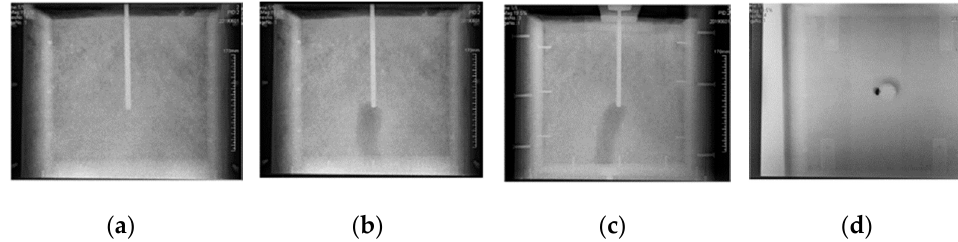
Figure 10. Images of modified soil with the SAP content of 0.25%: ( a ) Before breakdown; ( b ) front view; ( c ) side view; ( d ) top view.